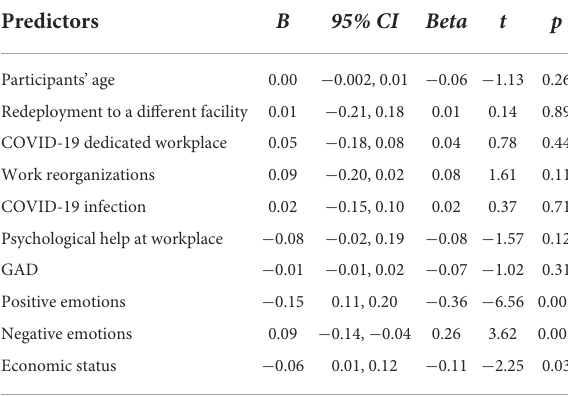
TABLE 5 Positive and negative emotions, GAD symptoms and economic status as predictors of